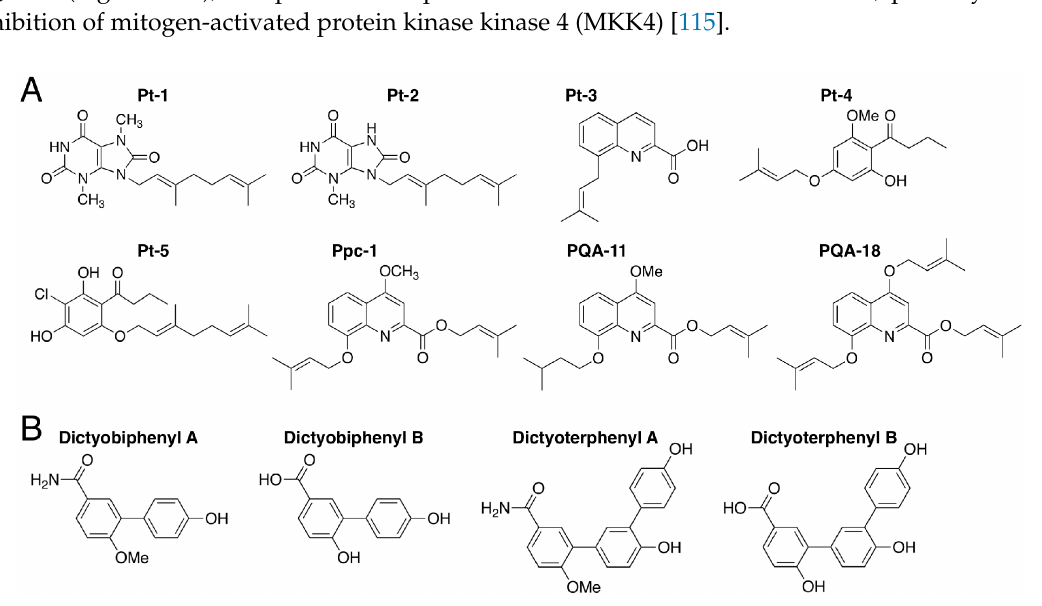
Figure 11. ( A ) Chemical structures of Pt ‐ 1–5 and Ppc ‐ 1 isolated from Polysphondylim tenuissimum and P. pseudo ‐ candidum and two derivatives of Ppc ‐ 1, PQA ‐ 11 and PQA ‐ 18; ( B ) Chemical structures of dictyobiphenyls A and B and dictyoterphenyls A and B, isolated from Dictyostelium polycephalum